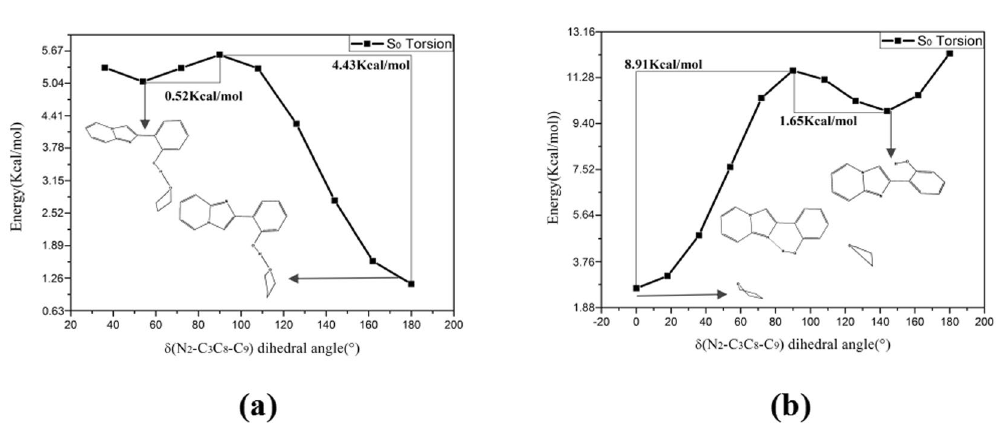
Figure 15. Constructed the potential energy curves of the o-HPIP ( a ) and np-HPIP ( b ): the energies of different structures versus the dihedral angles δ (N 2 -C 3 C 8 -C 9 ) in the S 0 state. The numerical values in the graph stand for the energy barriers of the torsion and reversed torsion